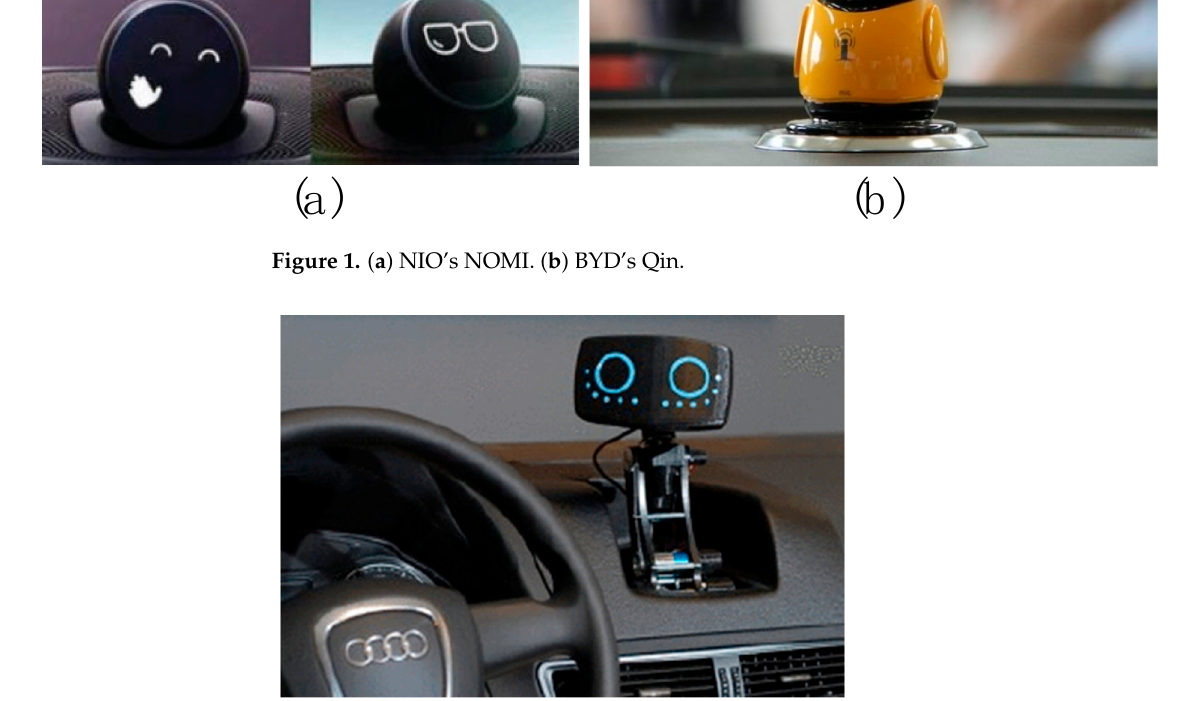
Figure 2. Kenton William ‘s AIDA.